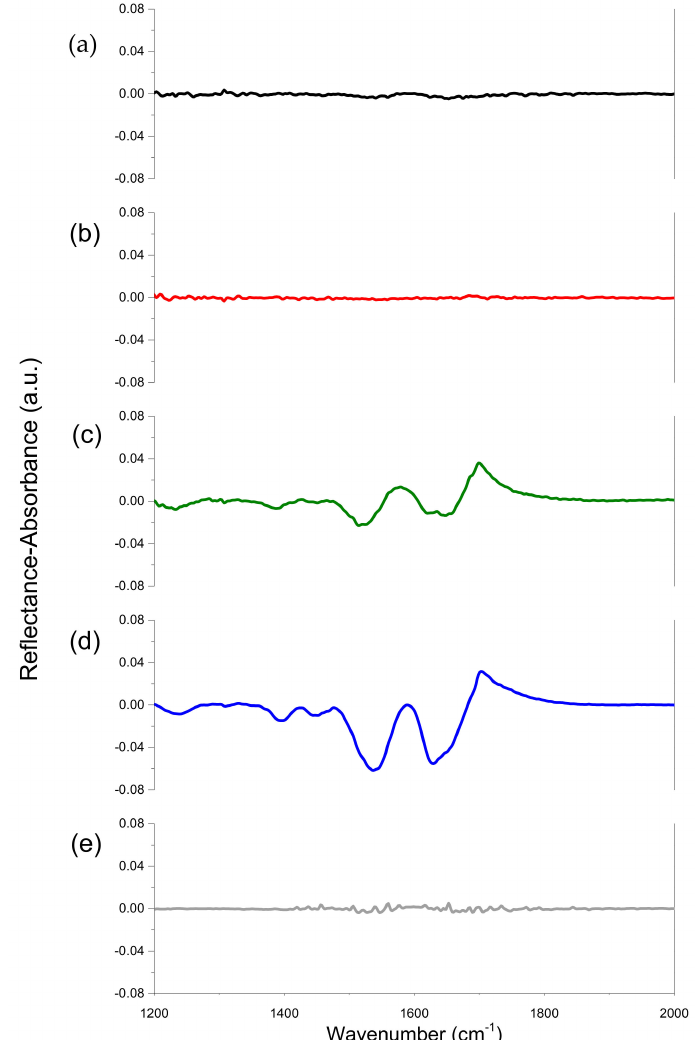
Figure 3. IRRAS spectra of spread layers of native LYS ( a ), LYS microgel ( b , c ), BLG microgel ( d ), native BLG ( e ). LYS (native and spherulites) was spread on 0.1 M NaCl solution at pH 10. The ( b ) corresponds to the beam reflection from the surface region far from that where the dispersion is spread and the green line corresponds to the beam reflection from the surface region where the spreading occurs. BLG (native and spherulites) was spread onto 0.1 M NaCl solution at pH